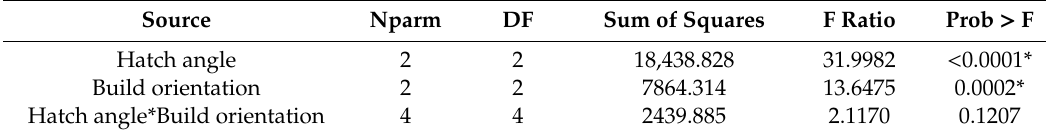
Table 8. E ff ects test for yield strength ( α = 0.05).